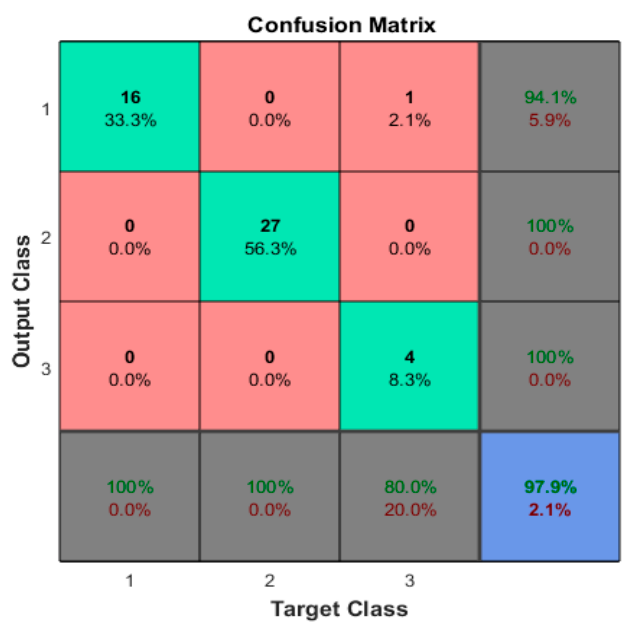
Figure 12. The confusion matrix of the classification result.